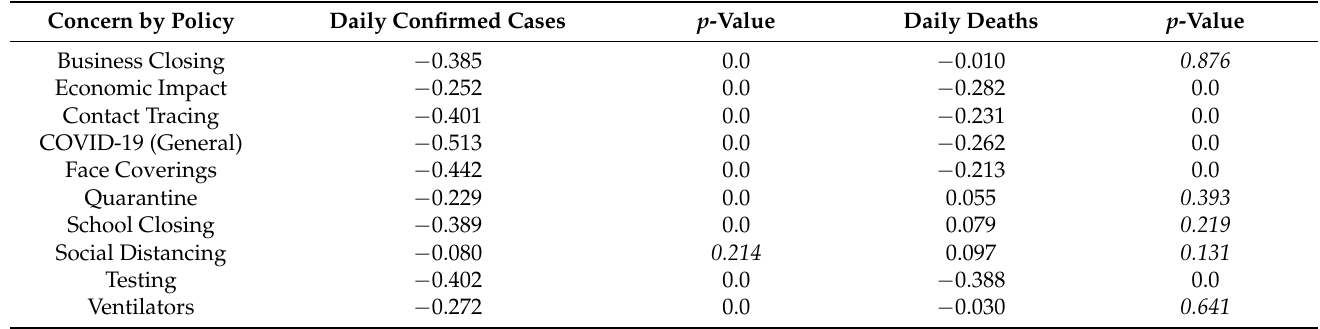
Table 5. Correlation Coefficients for Daily Confirmed Cases and Daily Deaths with Concern Levels about each Policy between August 2020 and March 2021. We marked all the non-significant p values in italics, using a cut-off value of p =